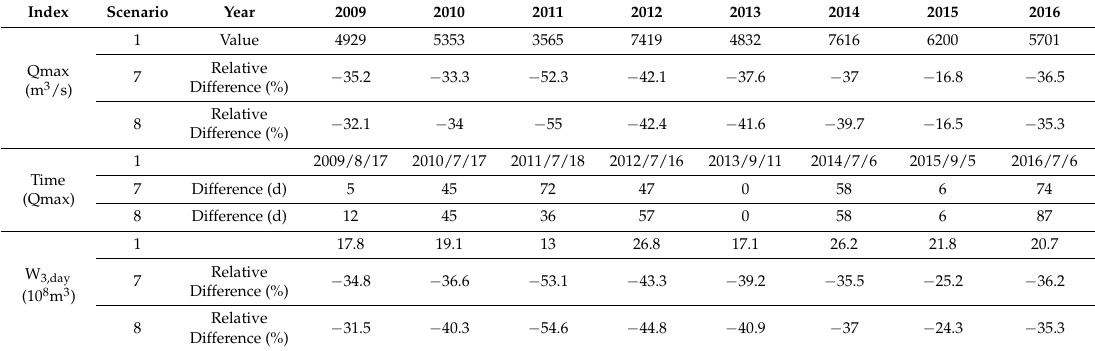
Table 8. Flood characteristics analysis at Ertan station (Scenarios 1 & 7–8). ( Q max represents